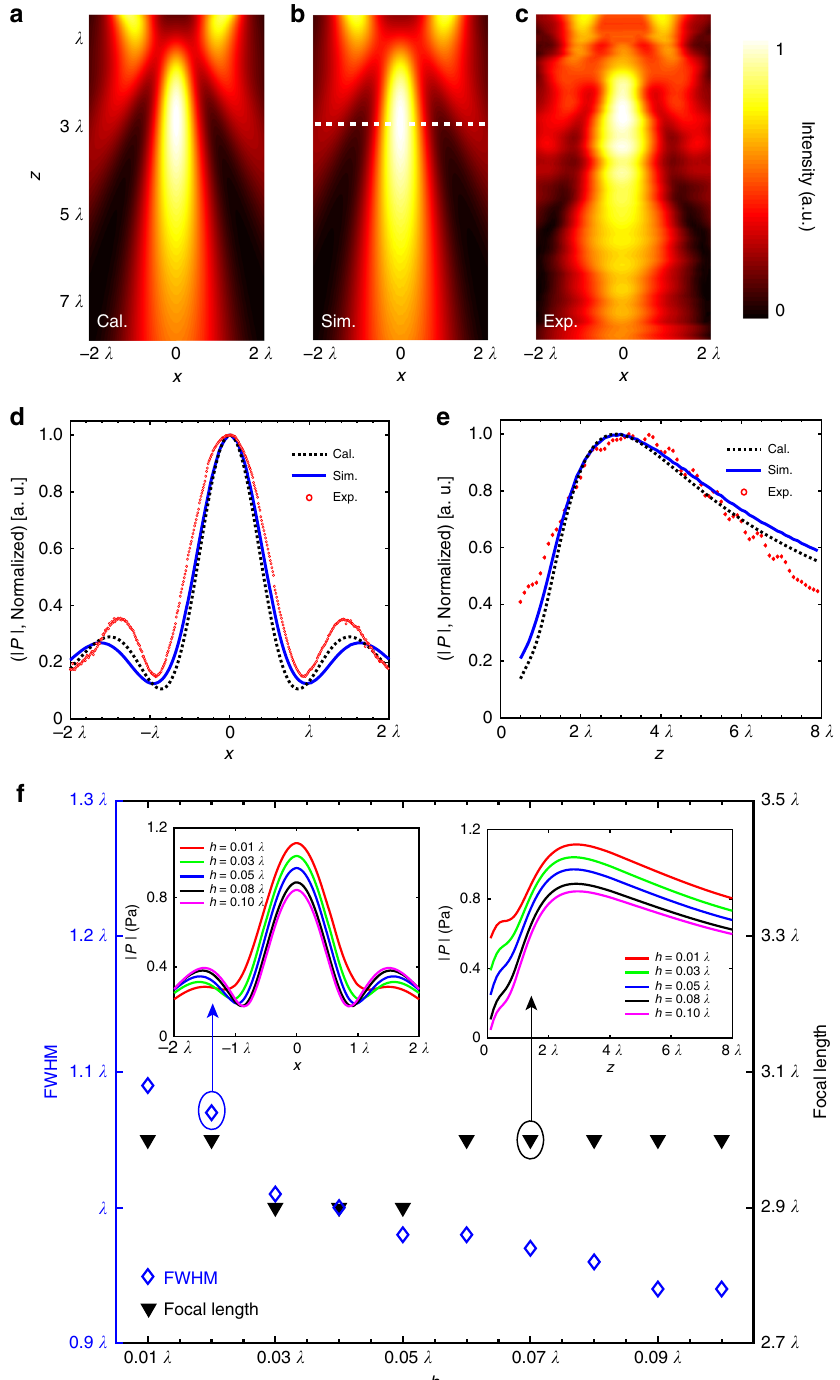
Fig. 3 Far- fi eld acoustic focusing. a – c Theoretical calculation, numerical simulation, and experimental measurement of the pressure fi eld, showing the normalized intensity maps after a normally incident plane wave transmits through the optimized metasurface lens. The white dashed line denotes the designated focal length. d , e The distributions of normalized pressure amplitude in cross sections of the focal spot along x direction and z direction, respectively. f Simulated full-width at half-maximum (FWHM) and focal length with different thicknesses of the acoustic metasurface varying in the range of [0.01 λ , 0.1 λ ]. The pro fi les of pressure amplitude through the focal spot are shown in the